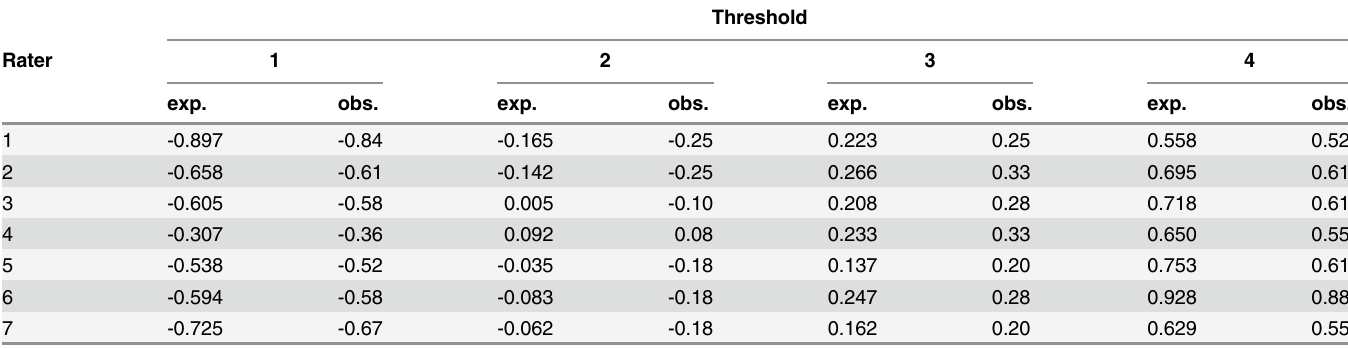
Table 5. Expected and observed threshold values for each